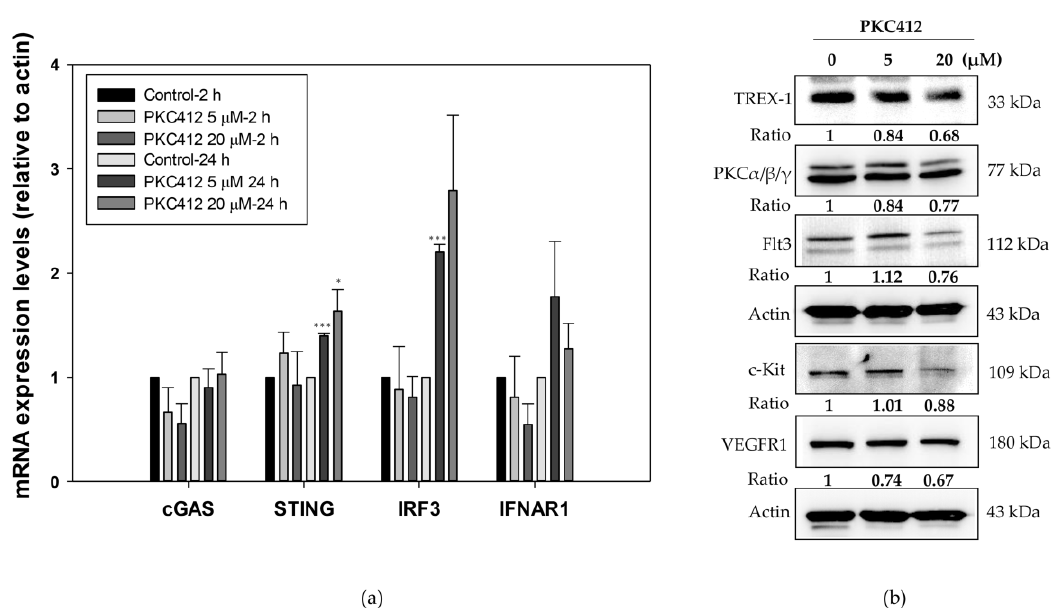
Figure 7. Effect of Trex-1 protein in midostaurin (PKC412)/FLT3L-treated colorectal adenocarci- noma cells. CT26 ( a ), HCT116 ( b ), and SW480 ( c ) cells were treated with PKC412 or/with FLT3L for 24 h and then cells were lysed and harvested. Equal amounts of proteins were subjected to im- munoblotting to detect Flt3 and Trex-1 proteins. Representative blots of target proteins were shown. The densitometric analysis of each band was shown in the bottom panel. Original Western Blot images can be found in Figure S1.